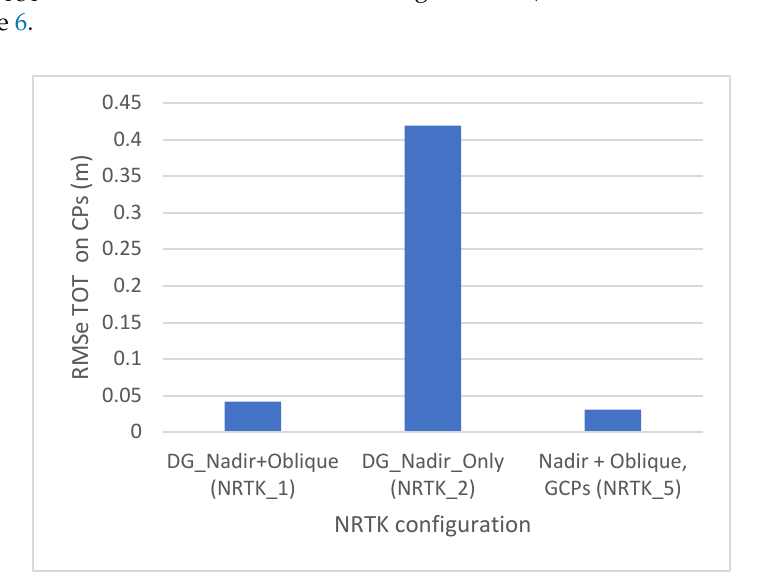
Table 14. DRTK approach. RMSE on CPs for configuration from NRTK_1 to NRTK_6.